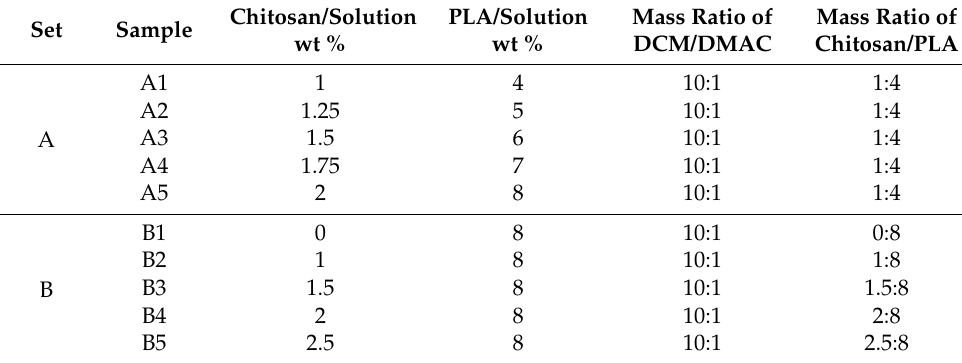
Table 1. Composition of electrospinning